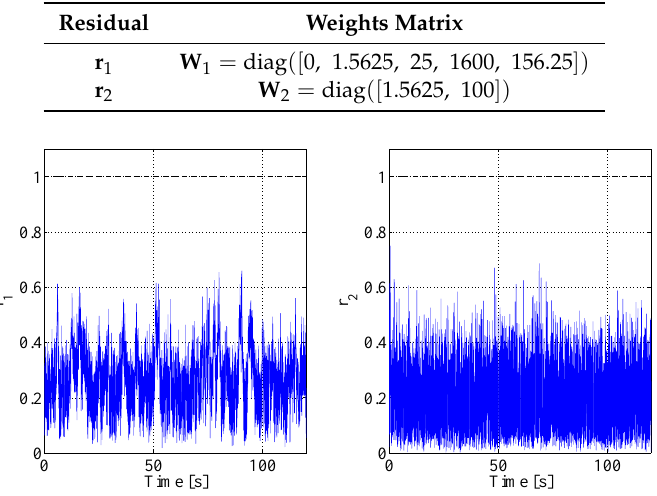
Figure 5. Residuals and thresholds: behaviour in absence of